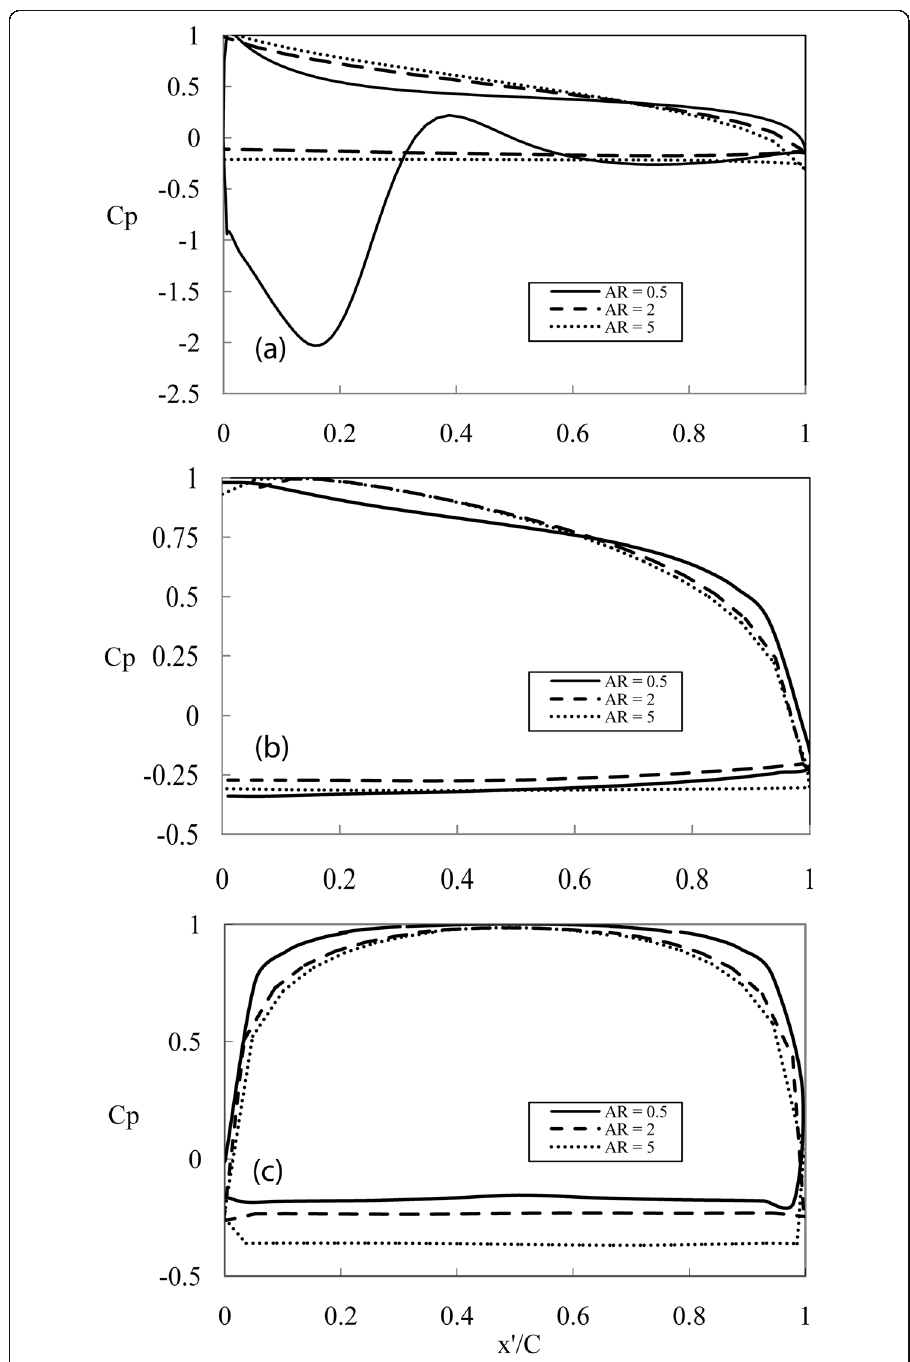
Fig. 6 Pressure coefficient (C P ) for different aspect ratios at a ) α = 30°, b ) α = 60°, c ) α =